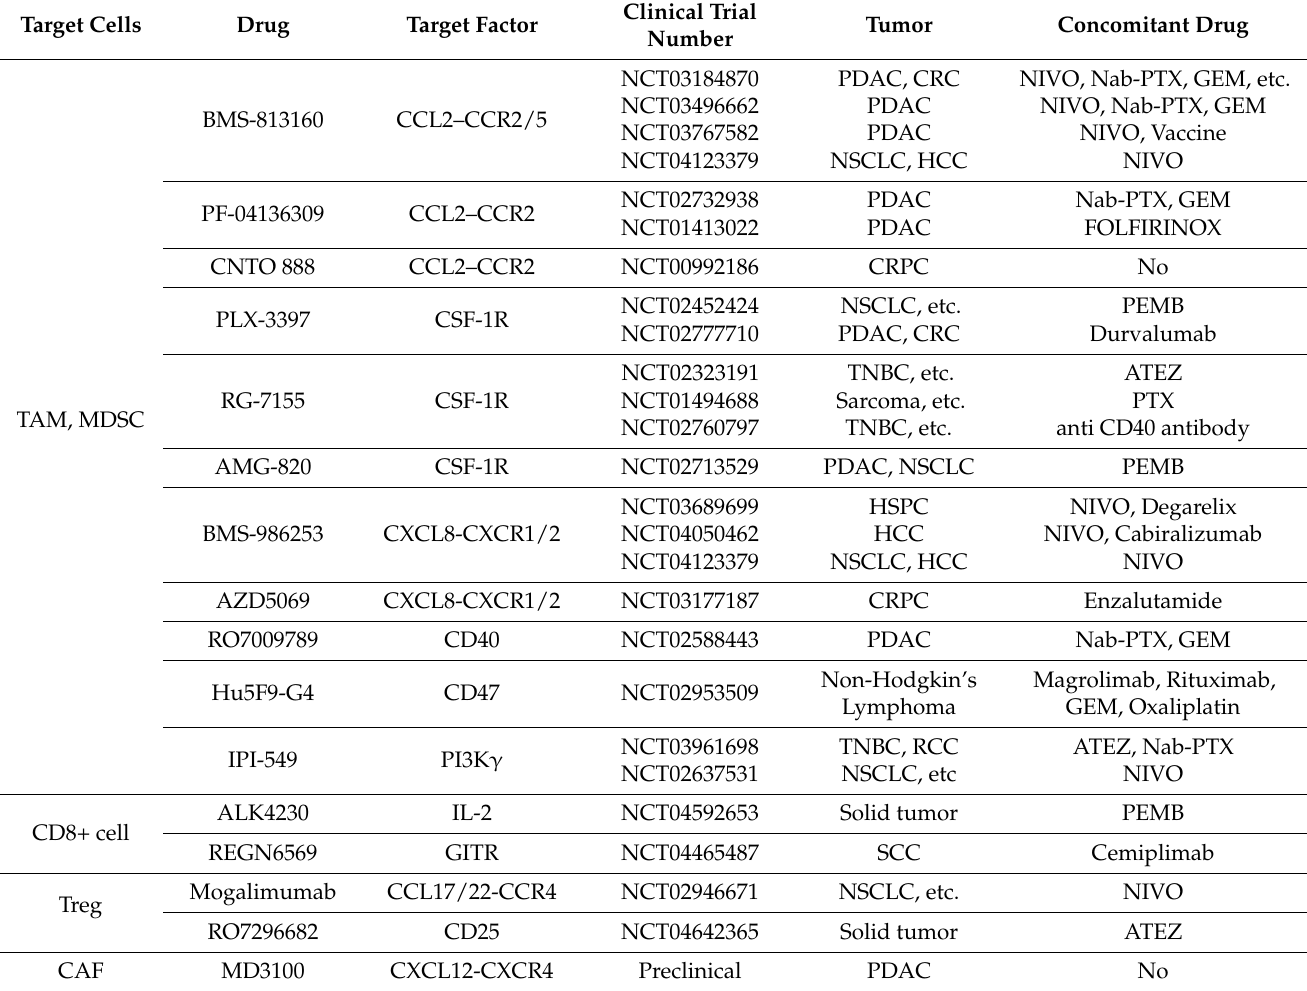
Table 1. Clinical trials targeting TME-related